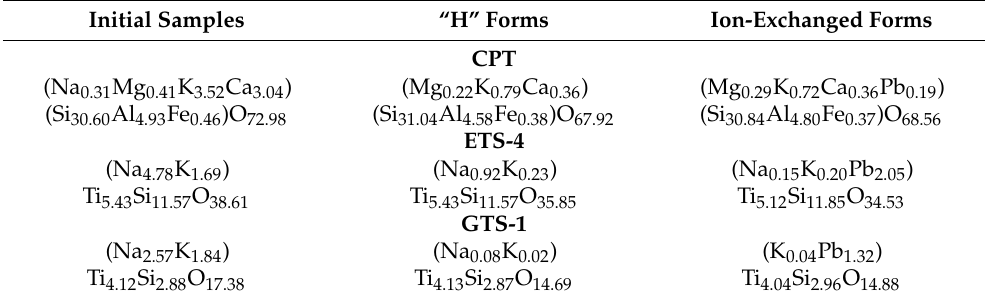
Table 1. Chemical composition of the initial samples, H-forms and Pb-forms obtained after 120 min of exchange at saturation